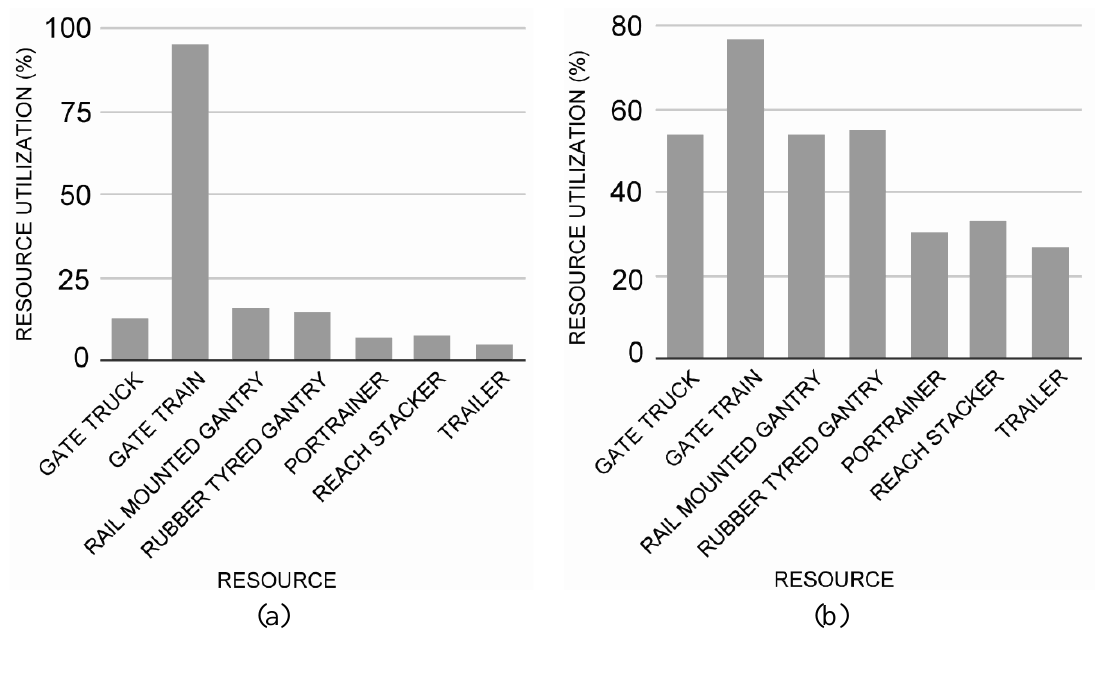
Figure 17. Resource utilization in the as-is ( a ) and to-be ( b )